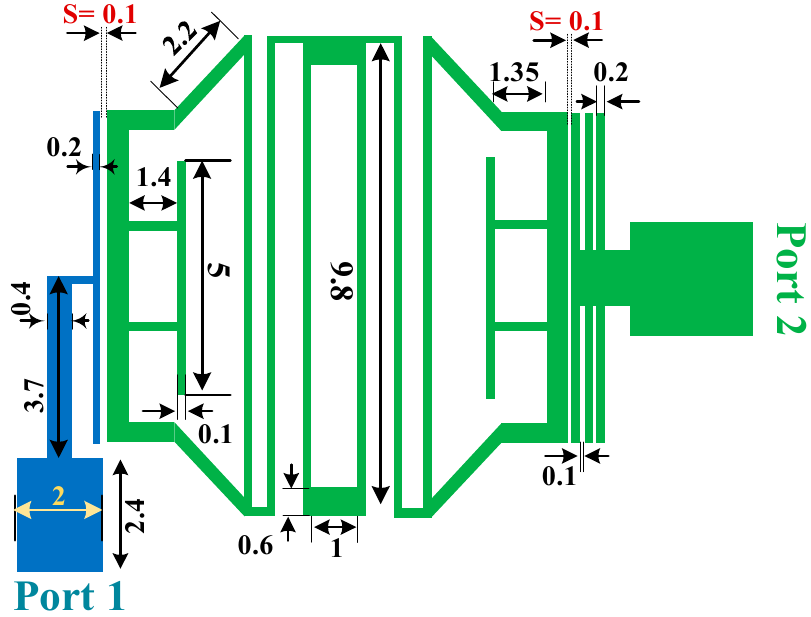
Figure 7. Structure of the second proposed BPF at 1.7/3.3 GHz.